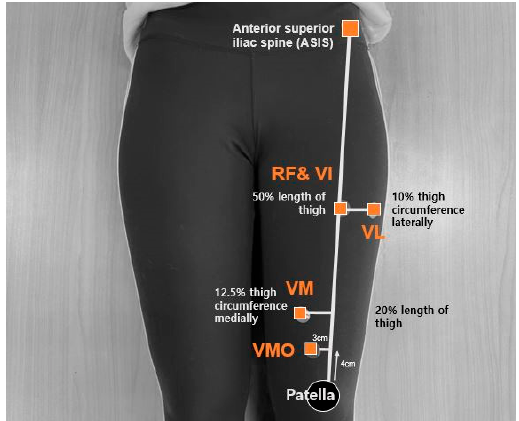
Figure 2. Location of quadriceps thickness measurement. RF: rectus femoris; VI: vastus intermedius; VL: vastus lateralis; VM: vastus medialis; VMO: vastus medialis oblique.